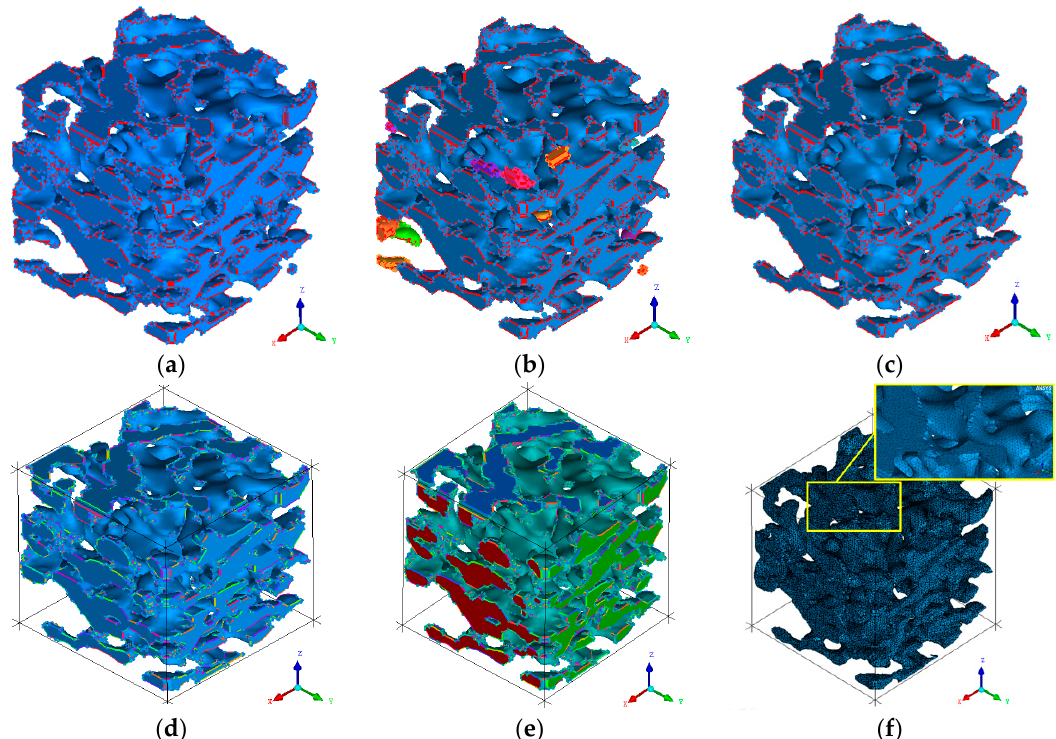
Figure 9. Optimization of coal micro-pore model and mesh generation on the ICEM platform: ( a ) Repair on the micro-pore structure model; ( b ) segmentation of islands; ( c ) deletion of islands; ( d ) establishment of topological structure; ( e ) setting of the import and export conditions; and ( f ) mesh generation.